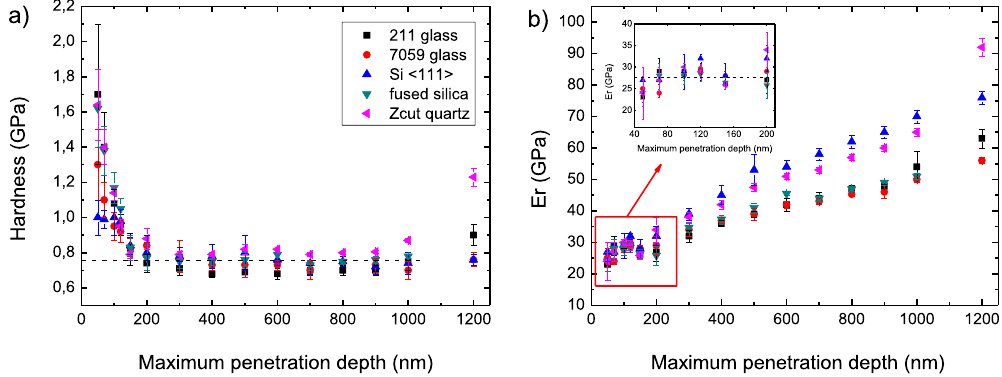
Figure 4. Maximum penetration depth dependence of hardness ( a ) and reduced Young’s modulus ( b ), obtained by nanoindentation for 2.2 μ m thick BiI 3 films deposited on 211 Precision glass, 7059 Corning glass, Z-cut quartz, 〈 111 〉 silicon and fused silica.